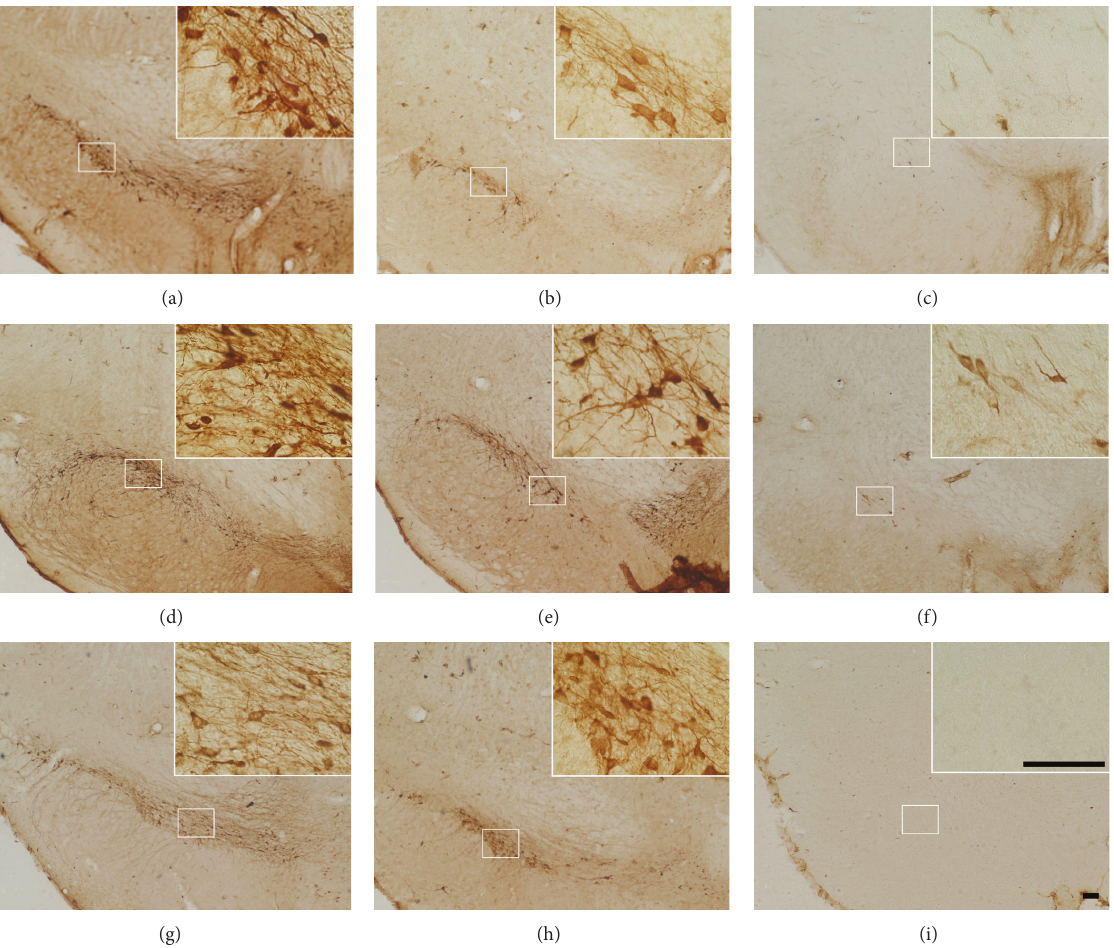
Figure 5: Tyrosine hydroxylase (TH) immunohistochemistry in the SNc and VTA. The numbers of TH-positive cells in the rAAV2-hGAD65 group were similar to that of the fibroblasts- (TH) and combination-treated groups at 4, 8, and 16 weeks after treatment. The lost number of the TH-positive neurons of SNc and VTA was decreased from 4 weeks to 16 weeks after treatment of all these three groups. At first, the cellular morphology was similar to the normal TH-positive neuron in the SNc and VTA (a, b, d, e, g, and h). At week 16, the TH-positive neurons were dramatically reduced, and neurites were shrunken or disrupted. In some model rats, there were no TH-positive neurons in SNc and VTA (c, f, and i). (a, b, and c) fibroblasts (TH) group at 4, 8, and 16 weeks after treatment, respectively; (d, e, and f), rAAV2-hGAD65 group at 4, 8, and 16 weeks after treatment; (g, h, and i), combination group at 4, 8, and 16 weeks after treatment, respectively. Bar = 100 𝜇